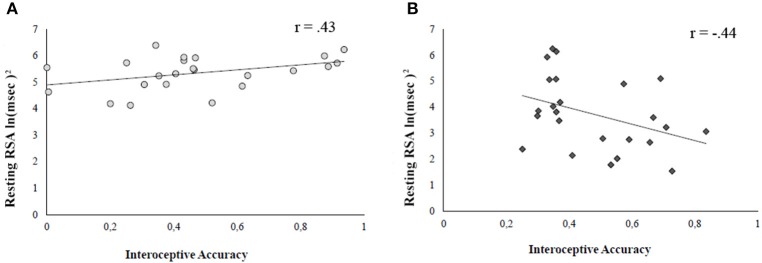
Pearson correlations between IA and resting RSA for both HCg (A) and ANg (B).